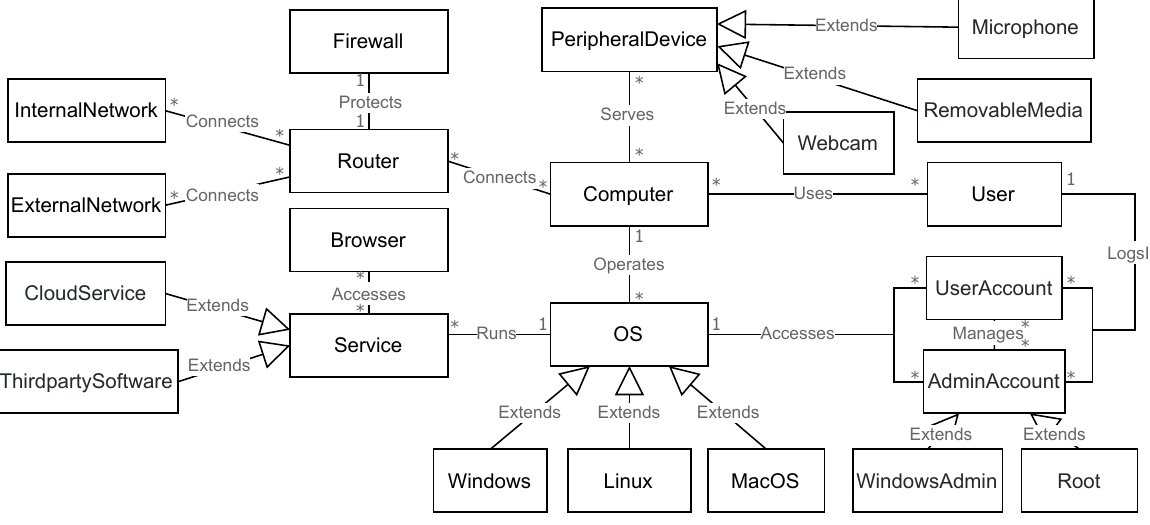
Figure 1. EnterpriseLang metamodel containing assets and associations